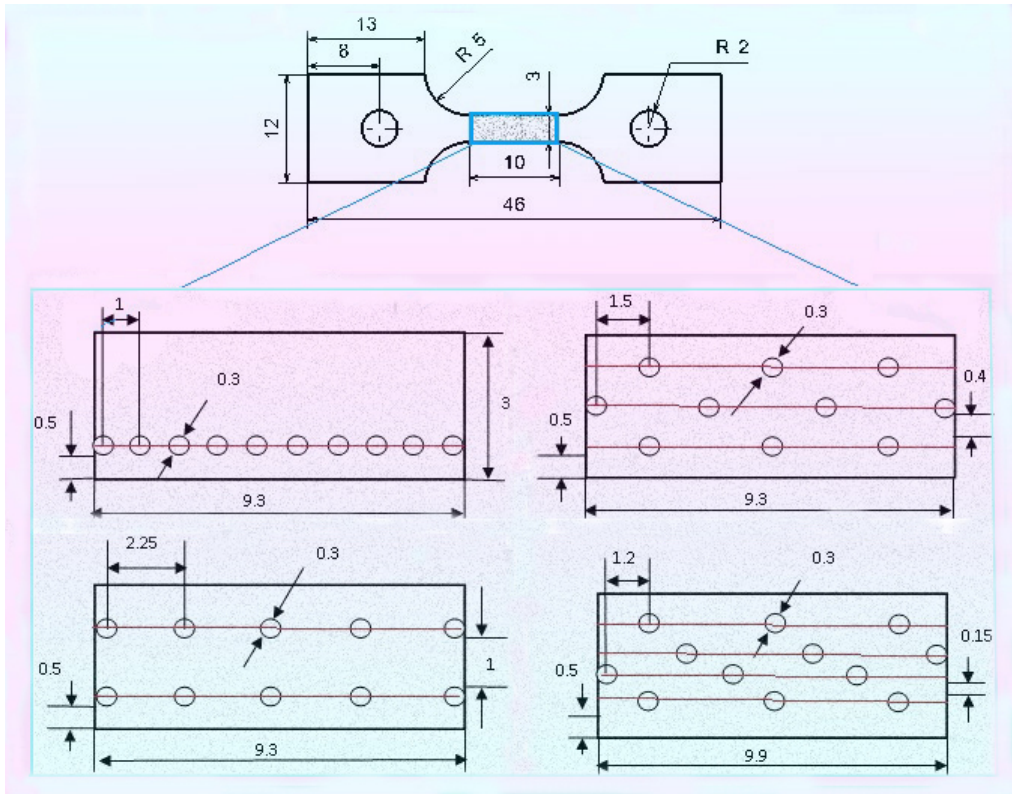
Figure 2. Diagram of the non-hole specimen and the detailed configurations of those withfilm-holes (dimension: